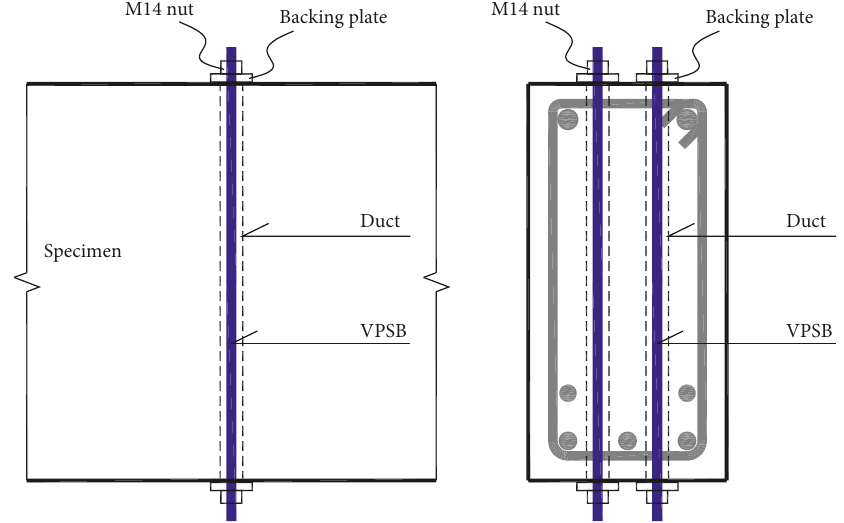
Figure 2: Structure form of a beam strengthened by